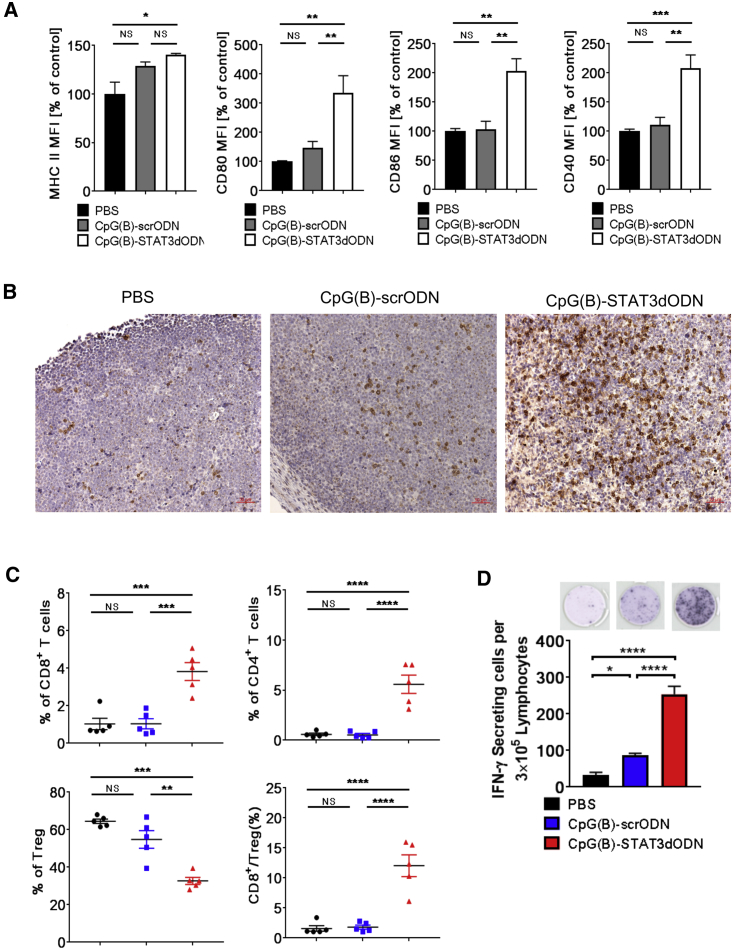
CpG(B)-STAT3dODN Treatment Results in B Cell-Lymphoma-Specific T Cell Immune Responses with Tumor Infiltration by CD8+ T CellsMice with s.c.-established A20 lymphoma were injected IT using 1 mg/kg CpG(B)-STAT3dODN, CpG-scrODN, or PBS 4 times every other day. Tumors were harvested and dispersed into single-cell suspensions for the phenotypic immune marker analysis using flow cytometry. (A) CpG(B)-STAT3dODN upregulates surface expression of MHC class-II, costimulatory CD40, CD80, and CD86 molecules. Data indicate means ± SEM (n = 5) from one of two independent experiments with similar outcomes. (B) CD8+ T cell infiltration in A20 lymphoma tumors visualized using immunohistochemical staining on FFPE tumor sections. Scale bars, 50 μm. (C) The infiltration by various T cell populations in A20 tumors were assessed using flow cytometry. Shown are percentages of total CD3+CD8+, CD3+CD4+ T cells, and CD3+CD4+Foxp3+ regulatory T cells (Tregs), as well as the ratio of CD3+CD8+ T cells to Tregs. (D) TLR9 stimulation combined with STAT3 inhibition generates A20 B cell-lymphoma-specific immune responses. Recall response to irradiated (100 Gy) A20 cells was assessed using single-cell suspensions prepared from tumor-draining lymph nodes from in vivo-treated mice as described above. Numbers of IFNγ-secreting cells were assessed using an ELISPOT assay. Upper panel: representative images; bottom panel: bar graphs representing results from one of two independent experiments. Data indicate means ± SEM (n = 5). *p < 0.05, **p < 0.01, ***p < 0.001, ****p ≤ 0.0001; FFPE, formalin-fixed, paraffin embedded; MFI, mean fluorescence intensity; NS, not significant.